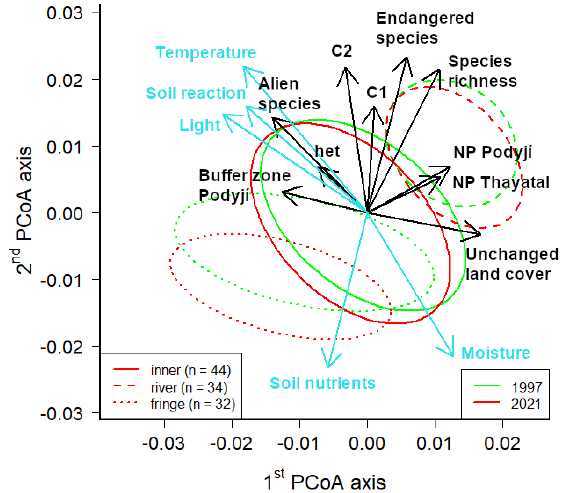
Figure 3. The principal coordinates analysis (PCoA) of the floristic data (Sörensen dissimilarity) of